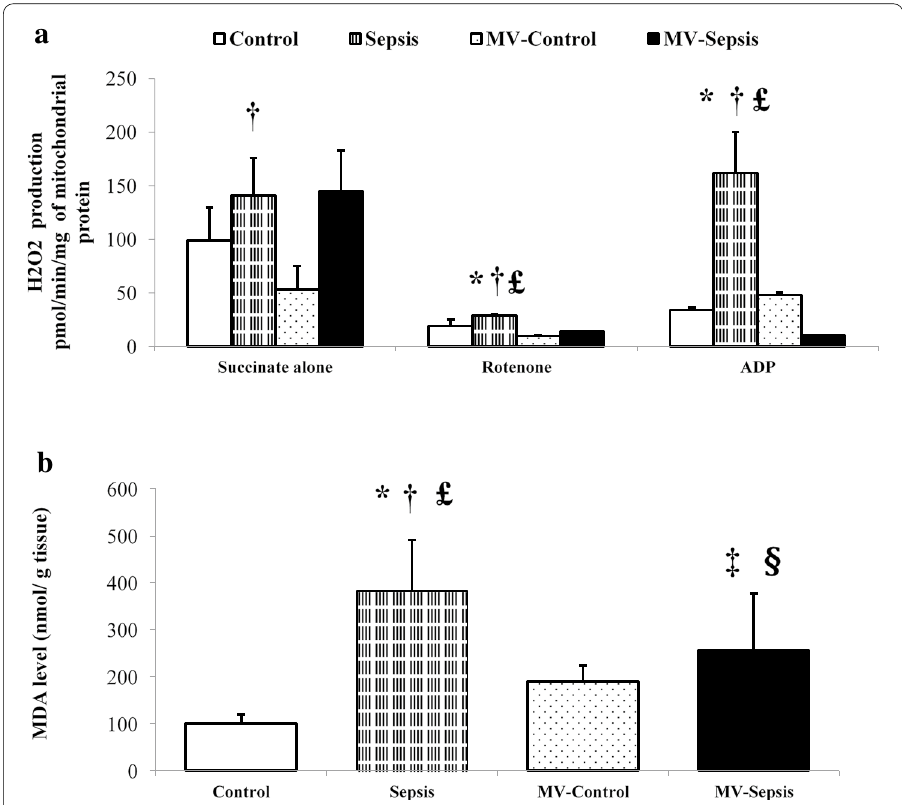
Fig. 4 Diaphragm mitochondrial H 2 O 2 production and MDA content. a Shows H 2 O 2 measured in the presence of 0.3% free fatty acid–BSA and 5 mM succinate without rotenone (succinate), then ADP (succinate‑state 3) added to increase mitochondrial activity ATP generation and inhibit H 2 O 2 generation, and then rotenone (rotenone) added to measure radical production at the level of complex 3, as described in “Materials and methods” section. Data are means SEM from 4 animals per group. * p < 0.05 sepsis versus ± control; † p < 0.05 sepsis versus MV‑control; £ p < 0.05 sepsis versus MV‑sepsis. b Shows MDA (malondialdehyde) content in the diaphragm of control, sepsis, MV‑sepsis, and MV‑control. Six hours after CLP, diaphragms were removed to determine thiobarbituric acid‑reactive species content. Data are means SEM from 6 animals per ± group. * p < 0.05 sepsis versus control; † p < 0.05 sepsis versus MV‑control; ‡ p < 0.05 MV‑sepsis versus control; § p < 0.05 MV‑sepsis versus MV‑control; £ p < 0.05 sepsis versus